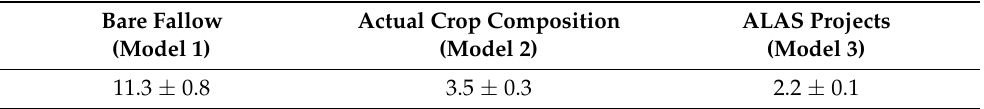
Table 3. Average annual erosion-induced soil losses (t/ha per year) in Belgorod Oblast, according to different land-use models (between the models 1 and 2, and the models 2 and 3, statistically significant differences are with a probability of over 99.999%, according to t